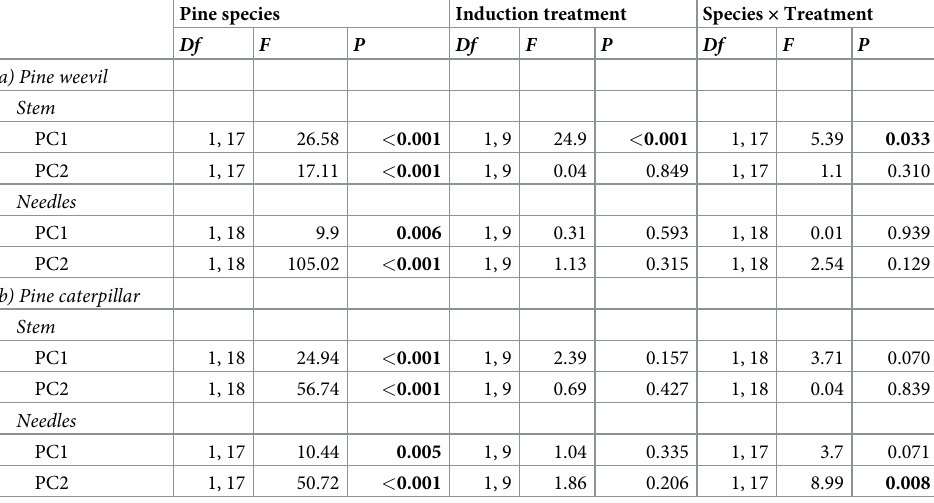
Table 5. Effects of the pine weevil (a) and pine caterpillar (b), as induction treatments, on the multivariate con- centration (PC1) and profile (PC2) of the main resin acids (principal components PC1 and PC2) in the stem and in the needle tissues of two pine species.